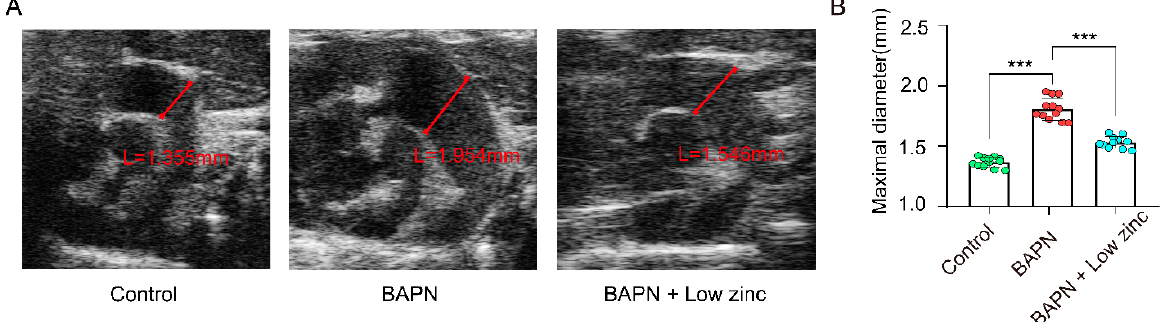
Figure 2. Echocardiography analysis at the end of the animal experiment (BAPN-induced 30 days) . ( A ) Representative ultrasound images of thoracic aortas. ( B ) Measurements of maximum aortic diameter, green blots represent control group, red blots represent BAPN group and blue blots represent BAPN + Low zinc group, n = 12 per group, by one-way ANOVA (*** p < 0.001).